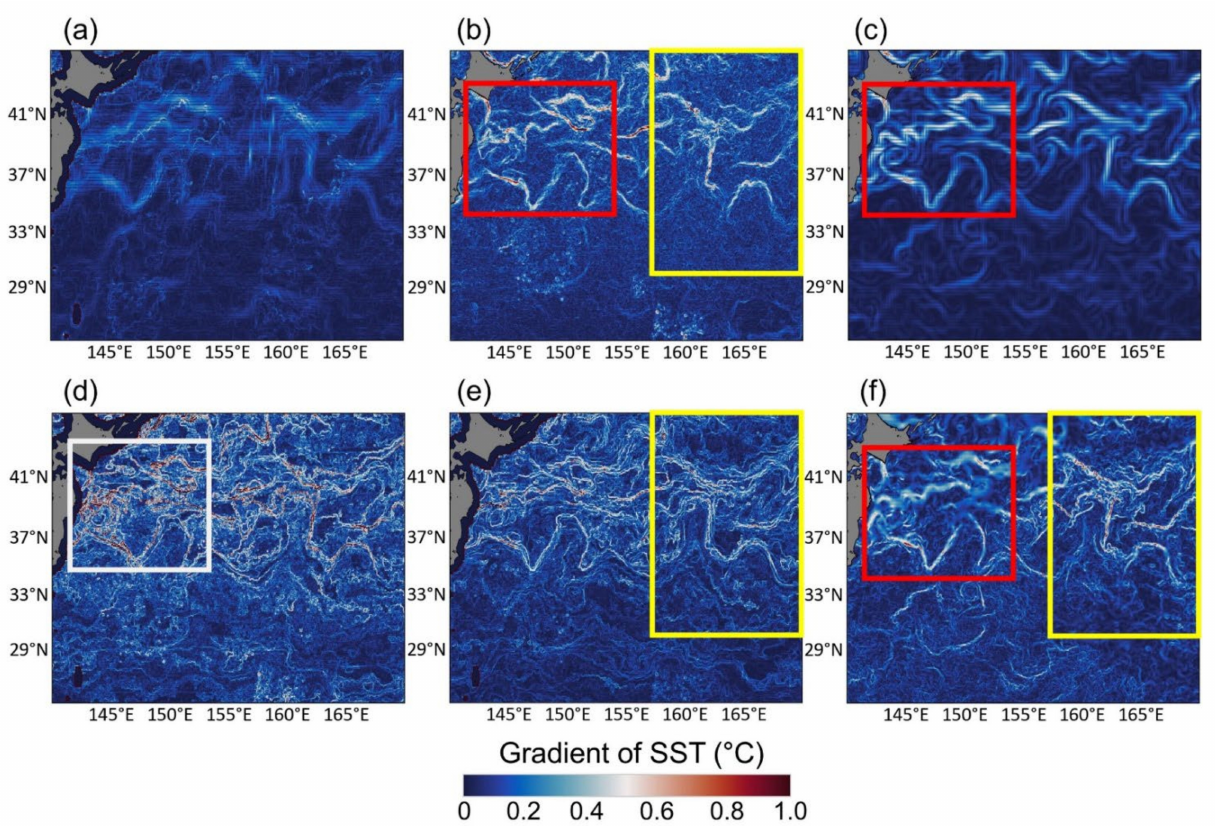
Figure 9. Spatial distribution of SST gradient fields on 6 November 2018: ( a ) the reconstructed AMSR2 SST, ( b ) the reconstructed MODIS SST, ( c ) OSTIA SST, ( d ) scheme 1-improved SST, ( e ) scheme 2-improved SST, and ( f ) multiscale ultra-high-resolution (MUR) SST. The spatial resolutions of the SST data are 10, 4, 4, and 4 km and 0.05 ◦ and 0.01 ◦ ,